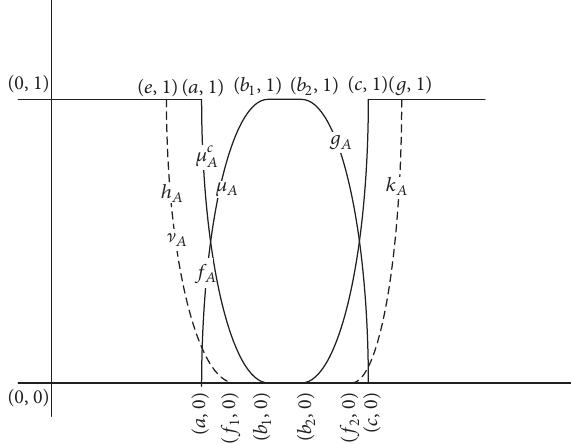
Figure 1: Intuitionistic fuzzy